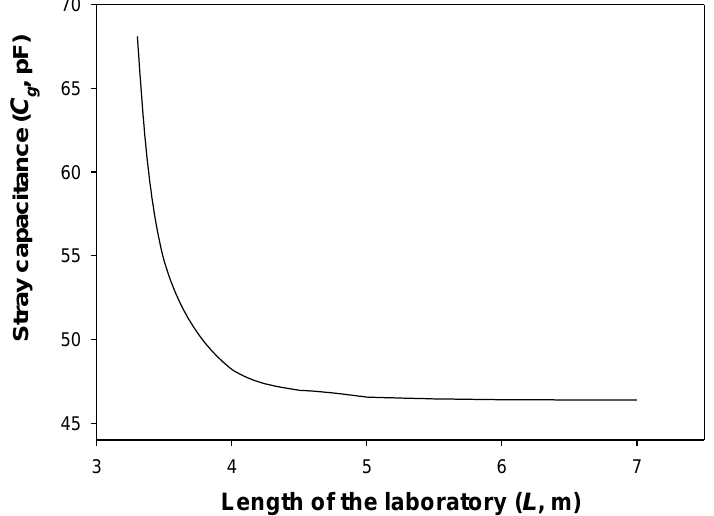
Figure 8. Effects of the length of the laboratory on the stray capacitance C g calculated by means of a parametric FEA simulation. The dimensions of the laboratory are (7.07 m, [3.3–7.0] m, 3.07 m) in the (x,y,z) axes, respectively.